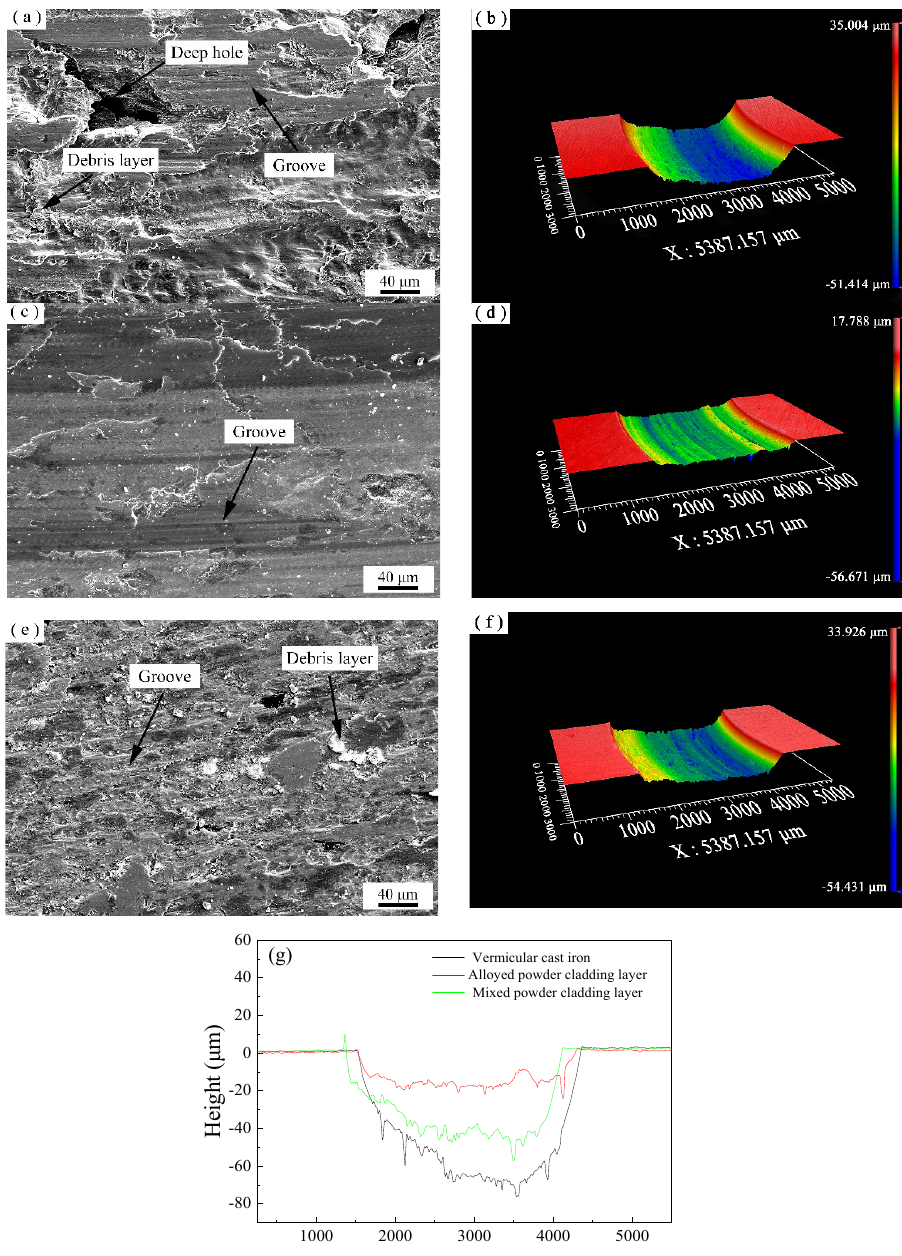
Figure 15. Worn surface morphologies and 3D profiles of counterpart disks: ( a , b ) vermicular cast iron; ( c , d ) the alloyed powder cladding layer; ( e , f ) the mixed powder cladding layer; ( g ) contrast diagram of wear depth on disk.